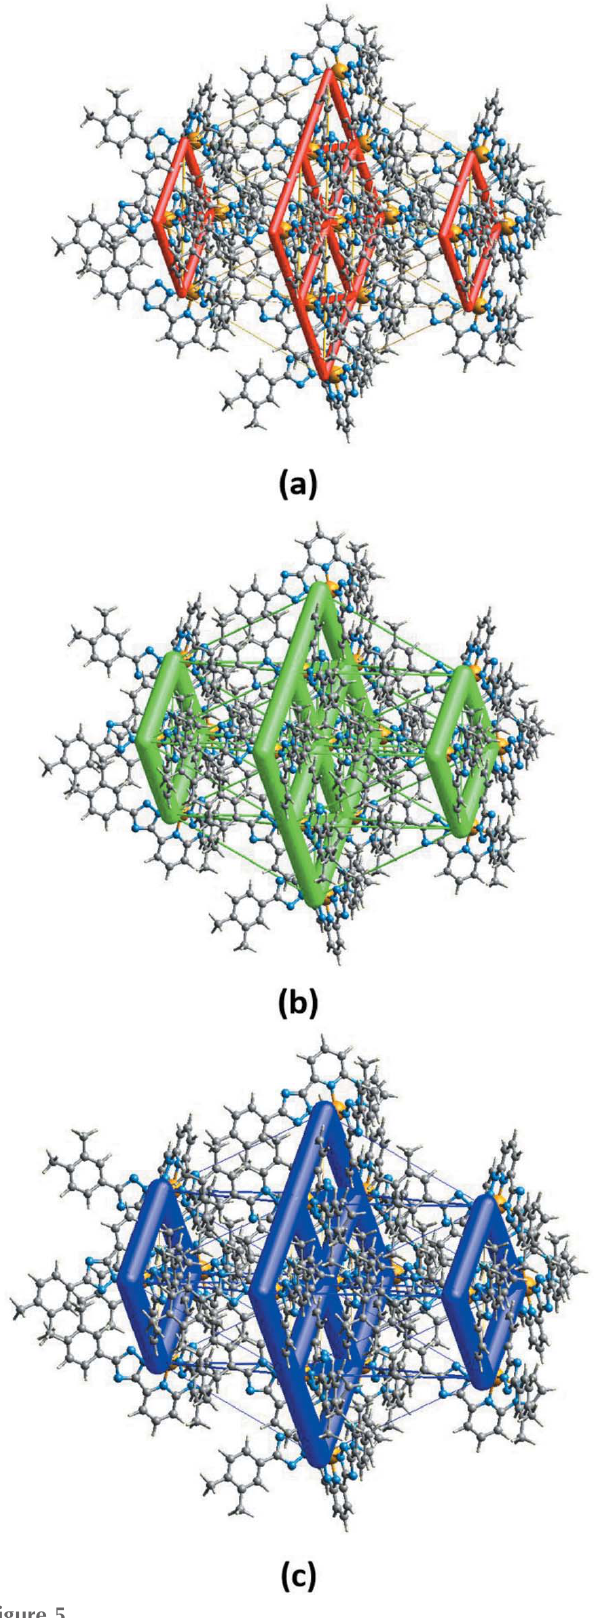
Figure 5 The calculated energy frameworks, showing ( a ) the electrostatic potential forces ( E ele ), ( b ) the dispersion forces ( E dis ) and ( c ) the total energy diagrams ( E tot ). Tube size is set at 100